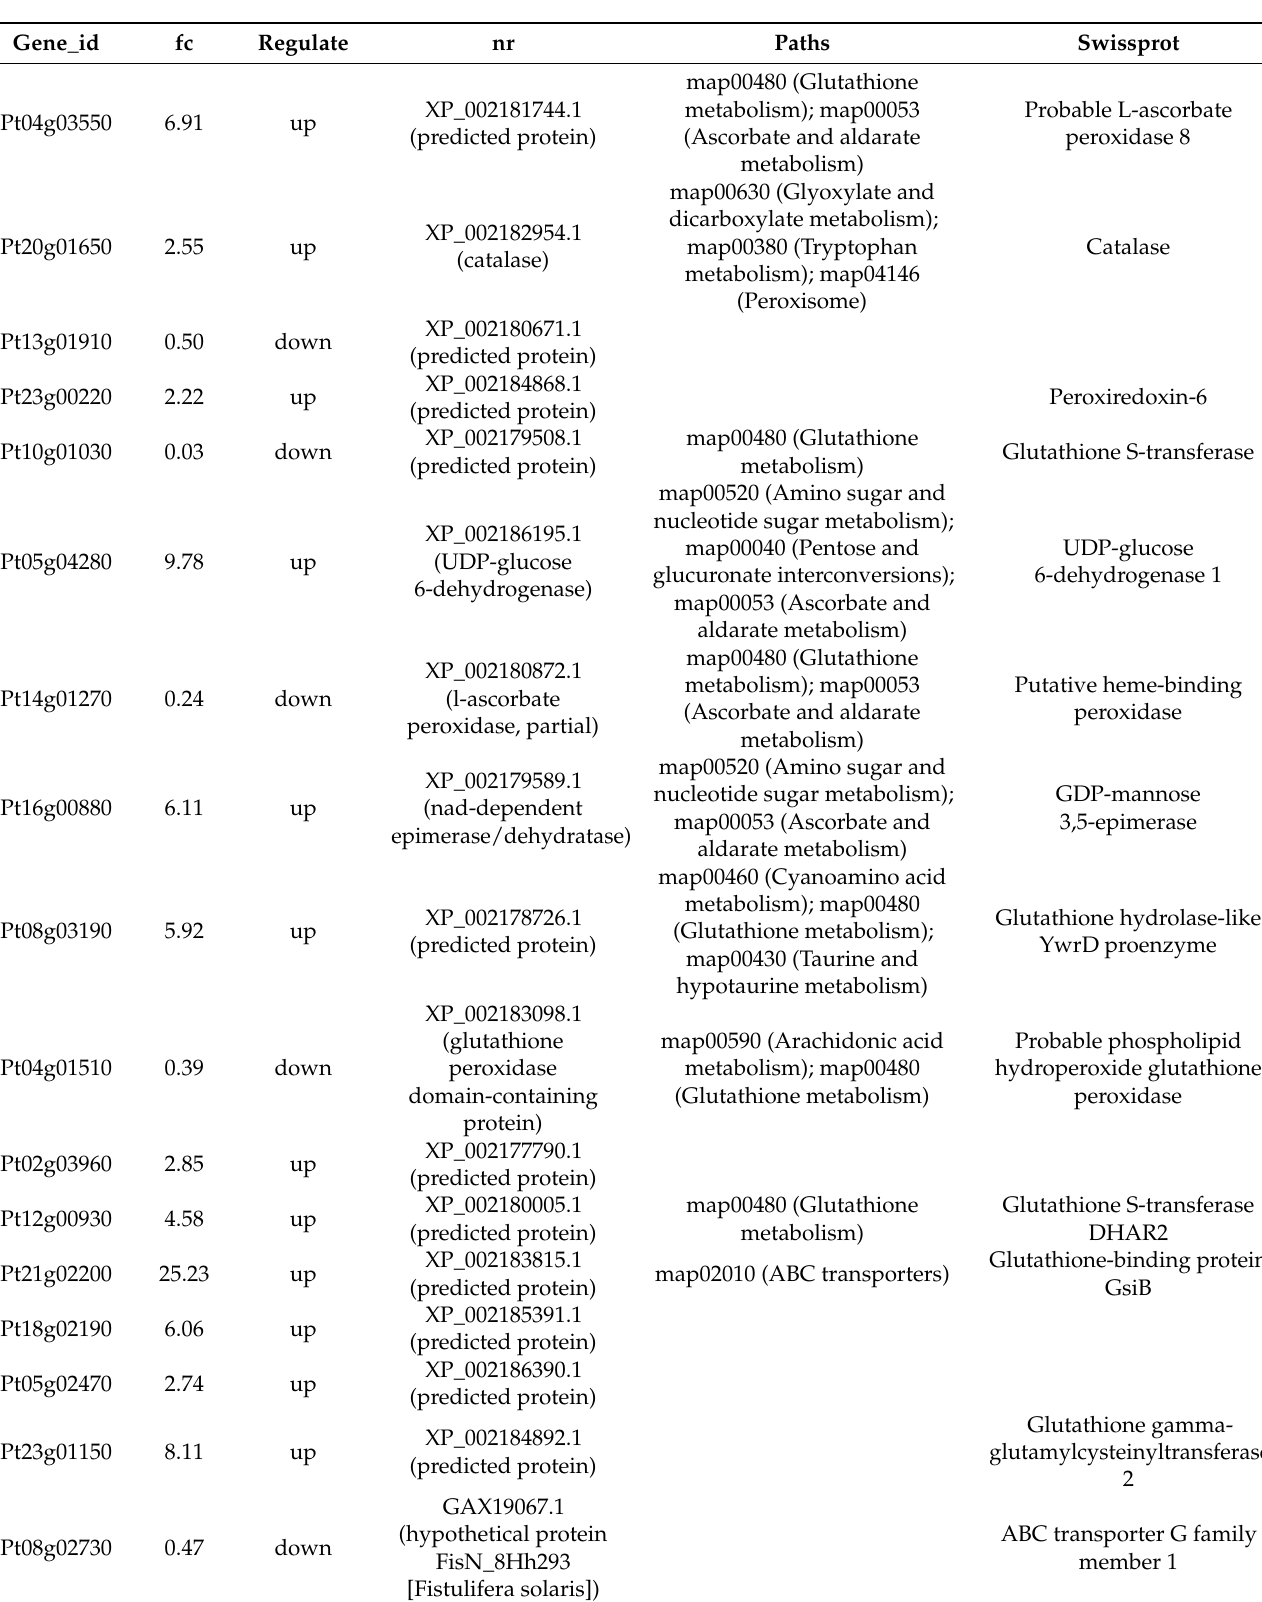
Table 2. DEGs involved in heavy metal stress response in P. tricornutum under Zn 2+